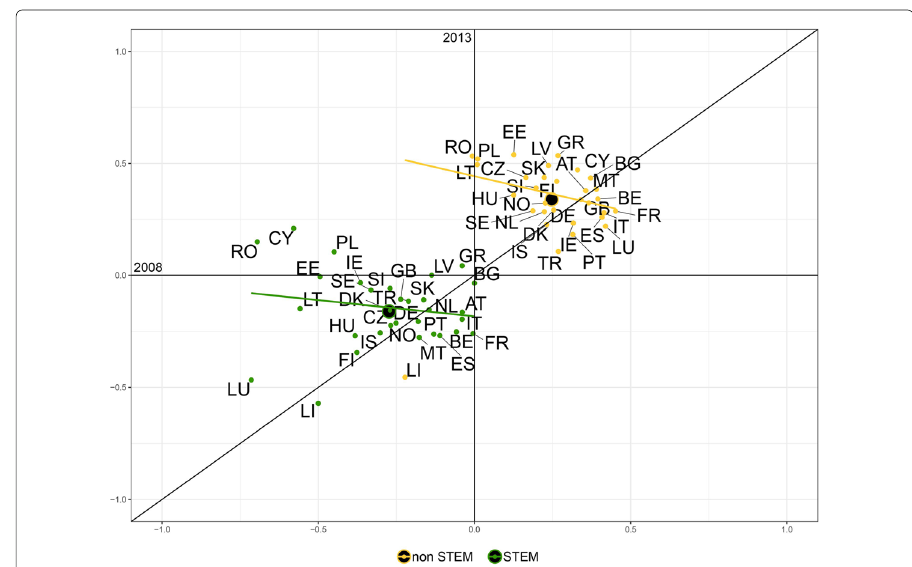
Fig. 6 Gender balance in the outgoing flows of students enrolled in STEM vs. non-STEM disciplines for the year 2008 against 2013. The scatter plot shows the F / M B measure for the outgoing flows of students for the years 2008 and 2013 by area of study. The STEM field is derived by summing the number of students in mobility in Engineering,manufacturingandconstruction , ICTs and Naturalsciences,mathematicsandstatistics , as coded following the ISCED-F 2013 classification. Non-STEM disciplines include Agriculture,forestry,fisheries andveterinary,ArtsandHumanities,Business,administrationandlaw,Education,Healthandwelfare,Services, Socialsciences,journalismandinformation . The fields Notknownorunspecified and Genericprogramsand qualifications are not included in either the two groups. The fitted lines are robust to outliers and